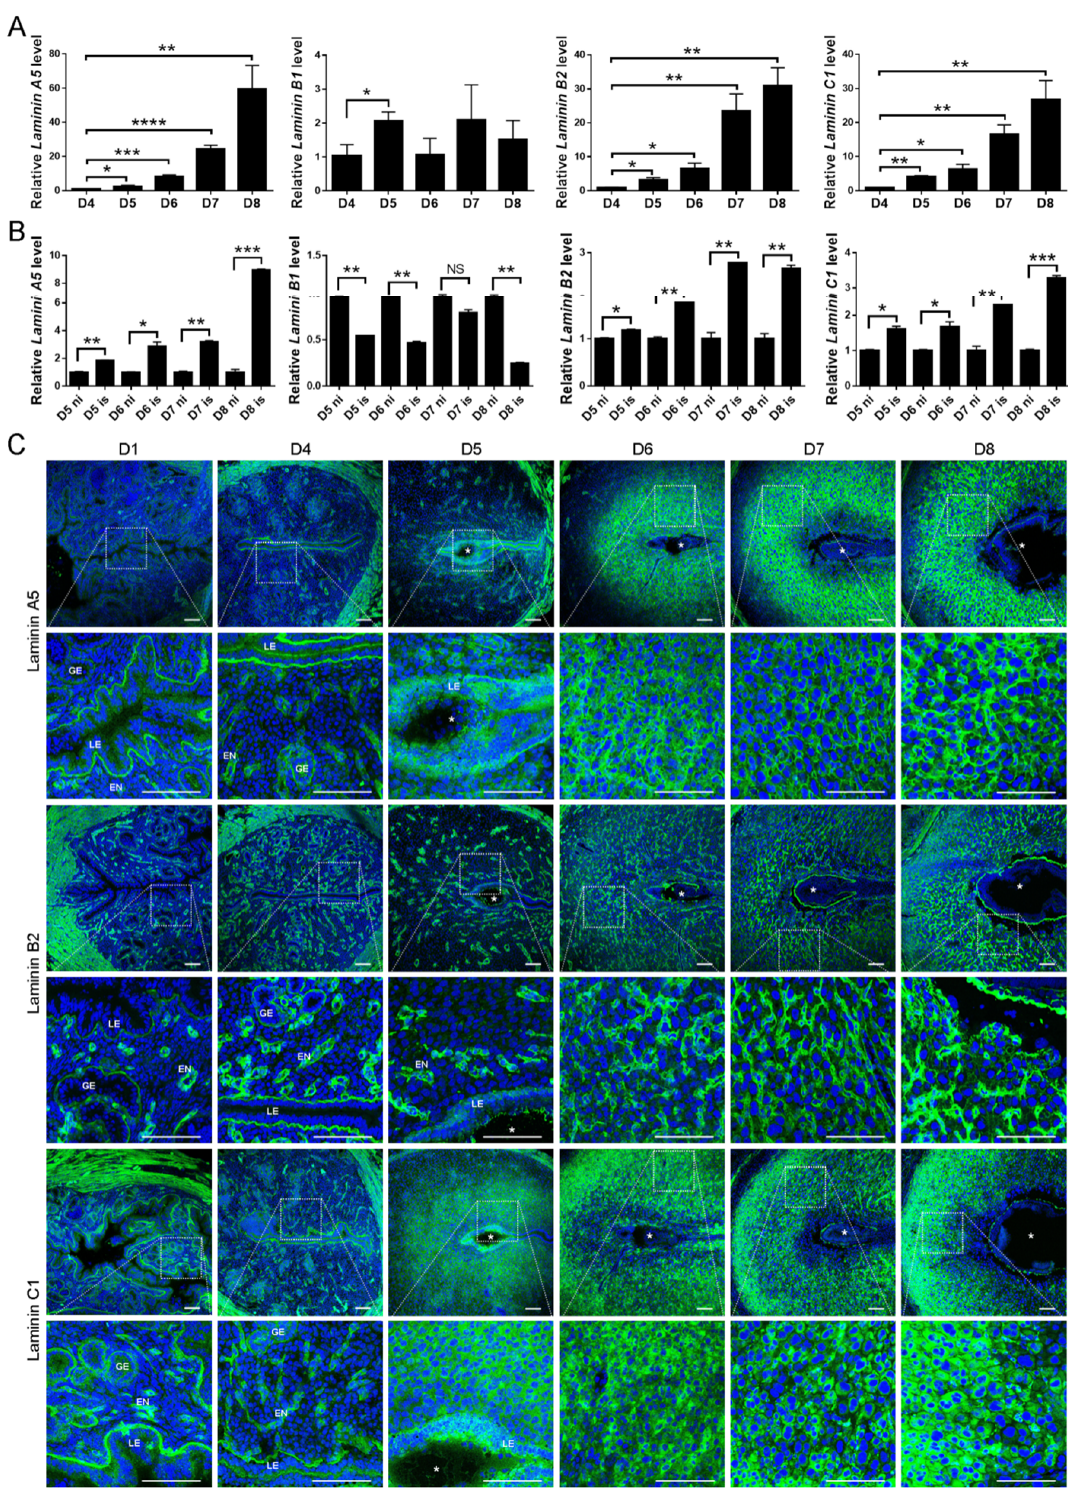
Figure 1. Laminin A5, B1, B2, and C1 expression in mouse uteri during early pregnancy. ( A ) RT ‐ qPCR analysis of Laminin A5, B1, B2, and C1 mRNA expression from days 4 to 8 of pregnancy. ( B ) RT ‐ qPCR analysis of Laminin A5, B1, B2, and C1 mRNA levels in mouse uteri at both implantation sites (is) and inter ‐ implantation sites (ni) from days 5 to 8 of pregnancy. ( C ) Immunofluorescence of laminin A5, B2, and C1 proteins from days 1 to 8 of pregnancy. *, embryo; EN, endothelium; GE, glandular epithelium; LE, luminal epithelium. Scale bar = 100 μ m. Bars represent mean ± SD (* p ‐ value < 0.05, ** p ‐ value < 0.01, *** p ‐ value < 0.001, **** p ‐ value < 0.0001). NS, not significant.